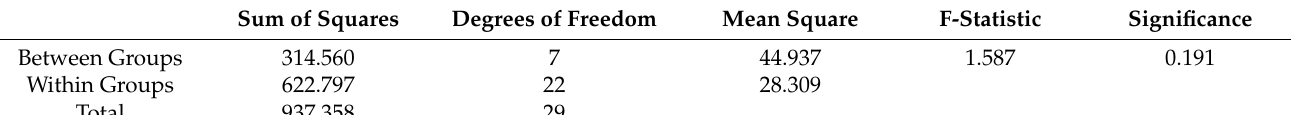
Table A5. Analysis of variance (ANOVA).